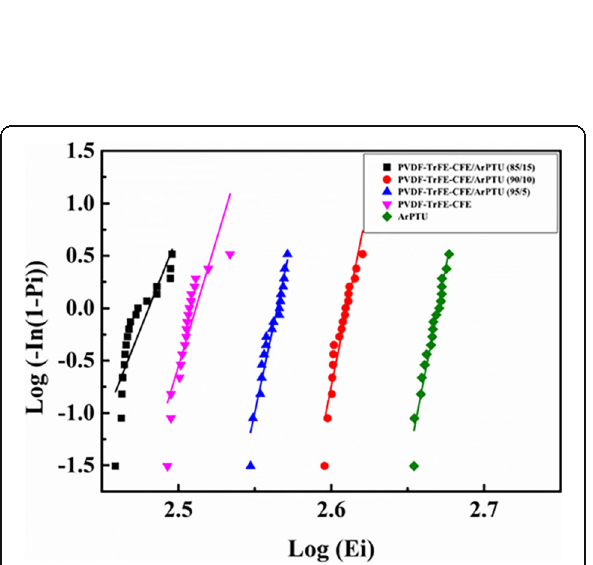
Fig. 7 Weibull breakdown of ArPTU, PVDF-TrFE-CFE, and PVDF-TrFE- CFE/ArPTU composite